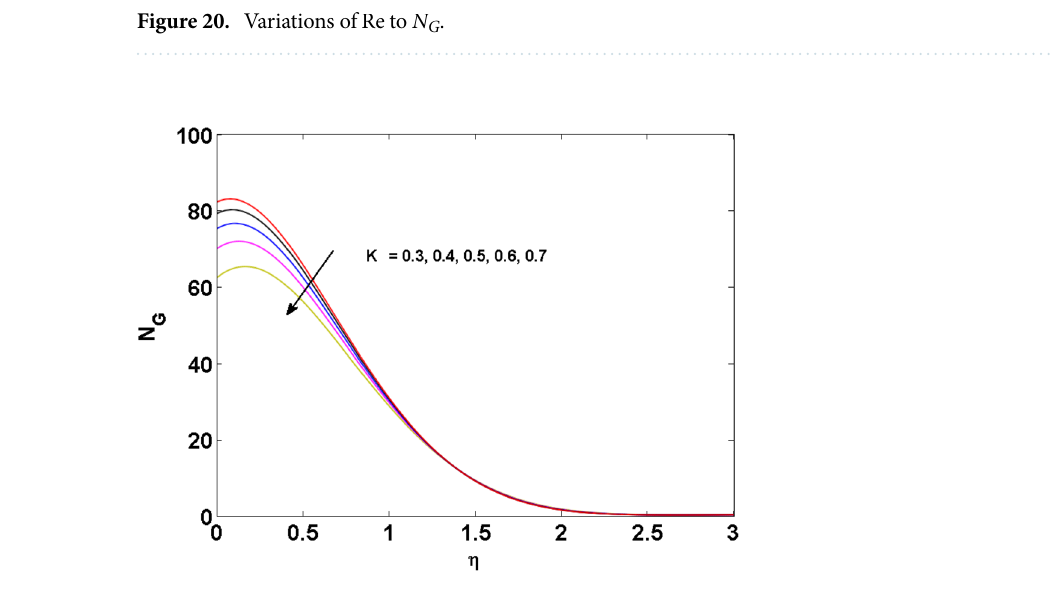
Figure 21. Variations of K to N G